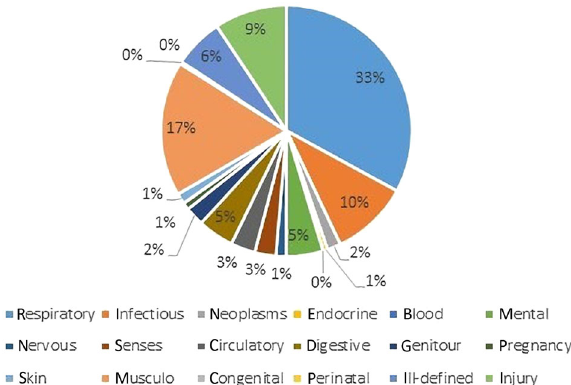
Fig. 3 Diagnoses causing work absence in the respiratory population.